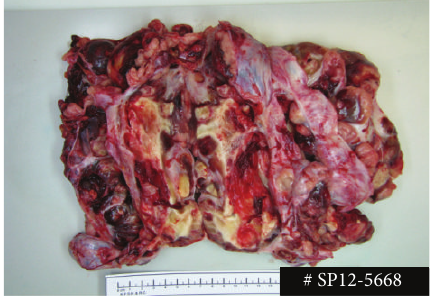
Figure 2: Macroscopic examination of the left ovarian mass. The mass weighed 1945 g and measured 24 × 21 × 7cm. The mass was well circumscribed and had whitish nodular outer surface. A break of ovarian capsule was noted for a distance measuring 5.5 cm. Cut-surface showed multiple nodules separated by fibrous septa. Some of nodules were necrotic and others had tan-yellow nodular